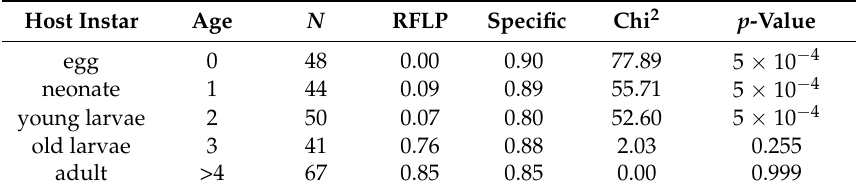
Table 3. Average estimates of parasitism rates by A. quadridentata in various codling moth instars (age in weeks) with two alternative PCR methods (diagnosis based on RFLP or with the Asco specific primer). Pearson’s chi-square tests were performed to compare estimates of the parasitism rate between both